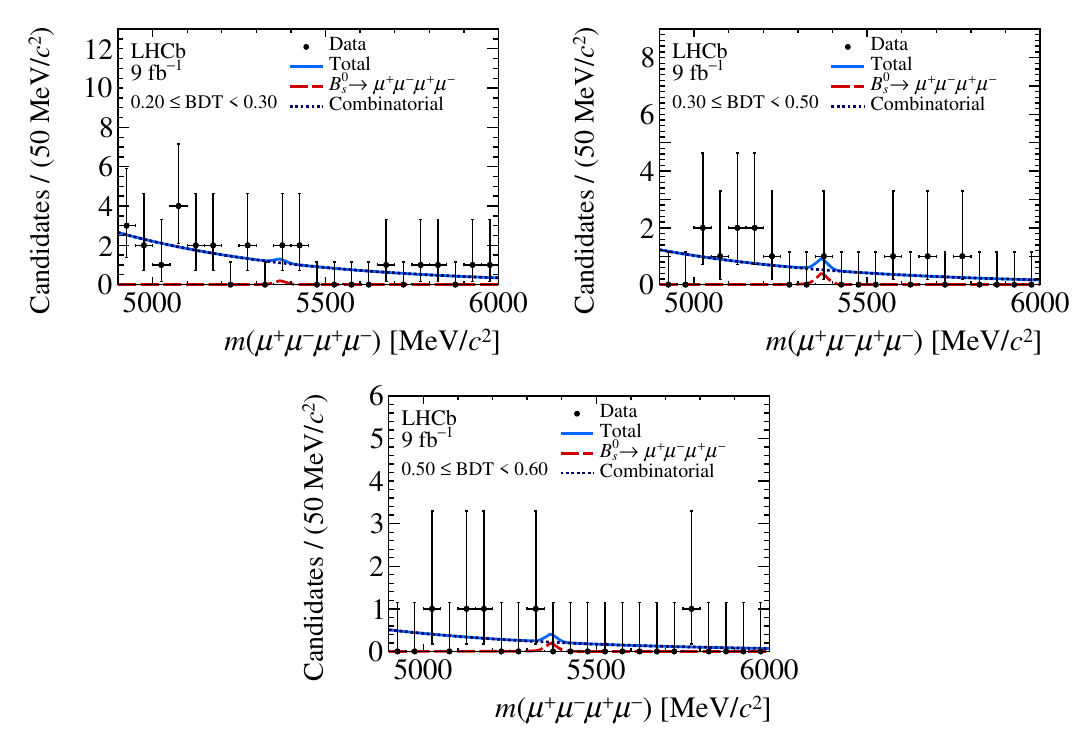
Figure 8 . Distribution of the µ + µ − µ + µ − invariant mass of candidates passing the B 0 → µ + µ − µ + µ − selection in (top left) the lowest BDT interval, (top right) the second lowest ( s ) BDT interval and (bottom) the second highest BDT interval, with the fit models used to determine the branching fraction of B 0 → µ + µ − µ + µ − s